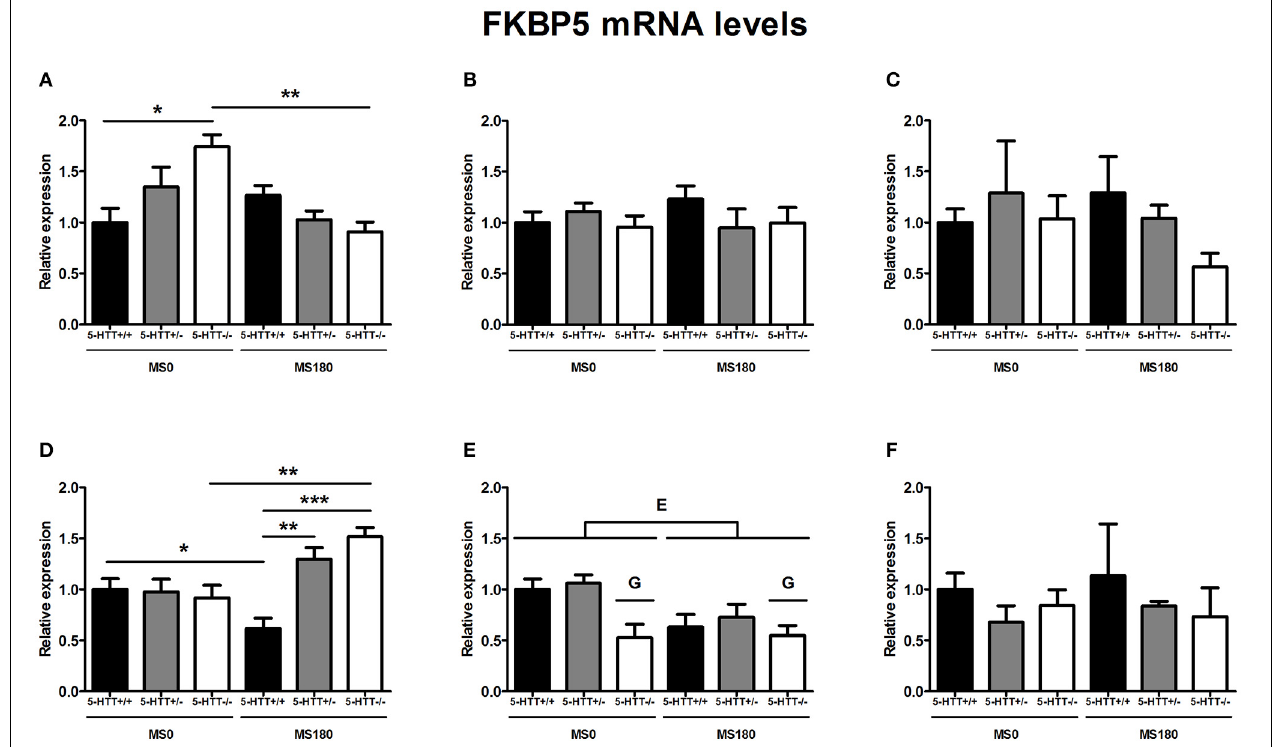
FIGURE 3 | FK506-binding protein 51 (FKBP5) mRNA levels in the dorsal medial prefrontal cortex (mPFC) (A) dorsal hippocampus (B) central amygdala (C) ventral mPFC (D) ventral hippocampus (E) and the anterodorsal bed nucleus of the stria terminalis (F) of serotonin transporter (5-HTT) homozygous knockout (5-HTT − / − ), heterozygous knockout (5-HTT + / − ), and wild-type (5-HTT + / + ) rats exposed to daily 3h separations (MS180) or a control treatment (MS0). FKBP5 mRNA levels in the dorsal and the ventral mPFC were found to be affected by a significant